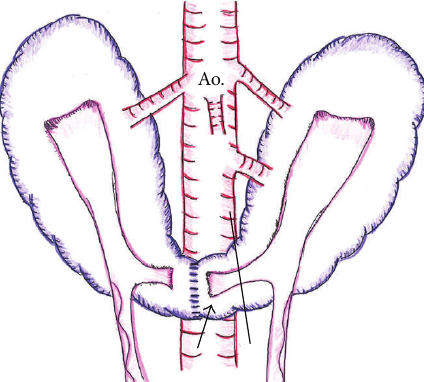
Figure 6: Illustration shows the horseshoe kidney with blood supplied from the aorta (Ao.) and collecting systems. The isthmus was divided on the left side position from the center (full line). A part of the left collecting system was preserved on the isthmus of the donor side